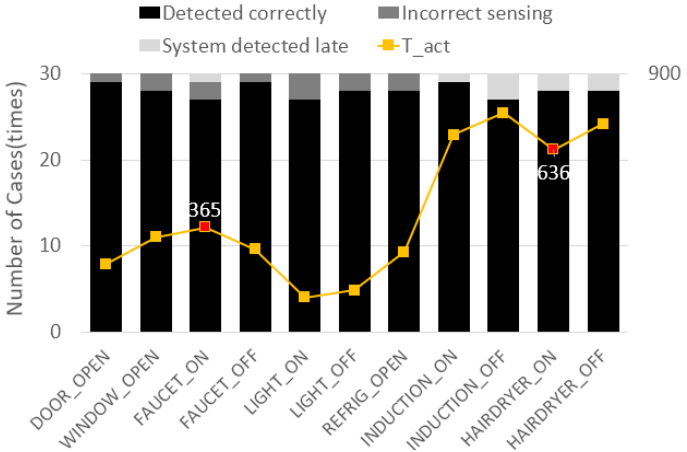
Figure 15. Detailed user behavior judging the results and the average value of the time gap 𝑻 𝐚𝐜𝐭